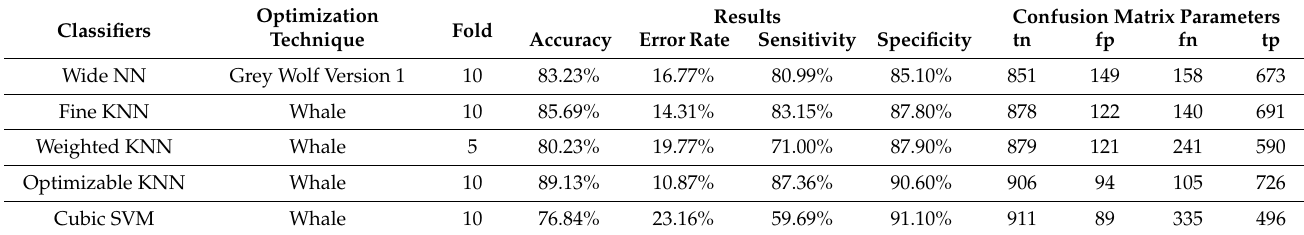
Table 5. Performance of various classifiers using Hu’s invariant moments.